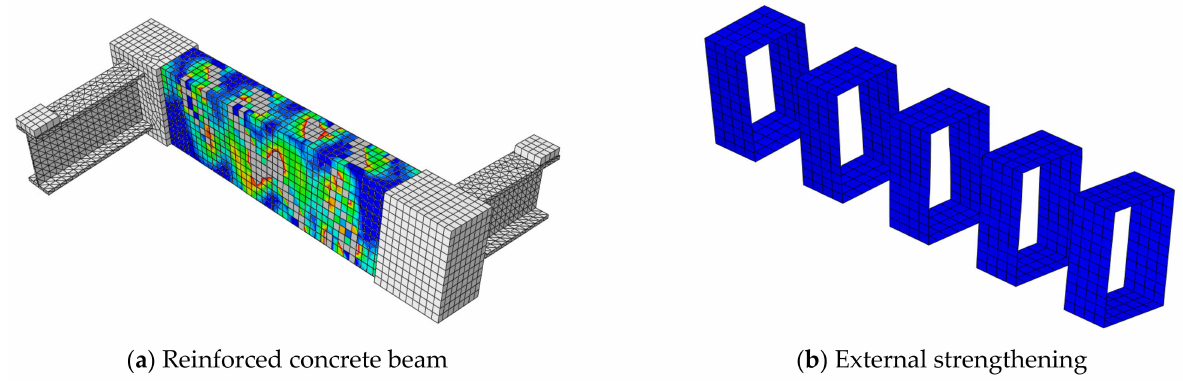
Figure 31. FE final cracks of beam B2-SS at the ultimate torque.